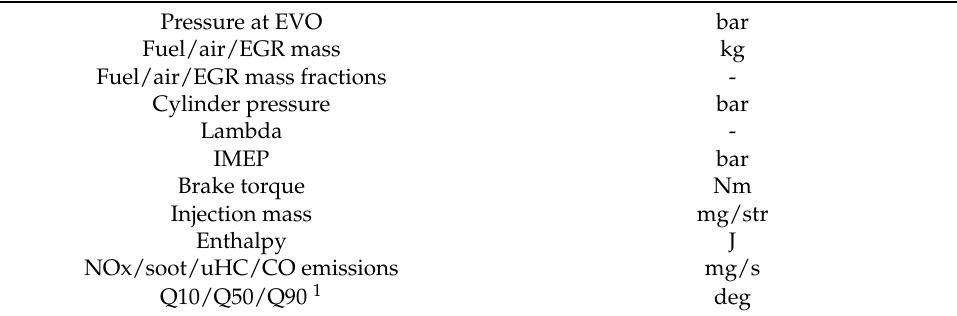
Table 7. Model output specification with required